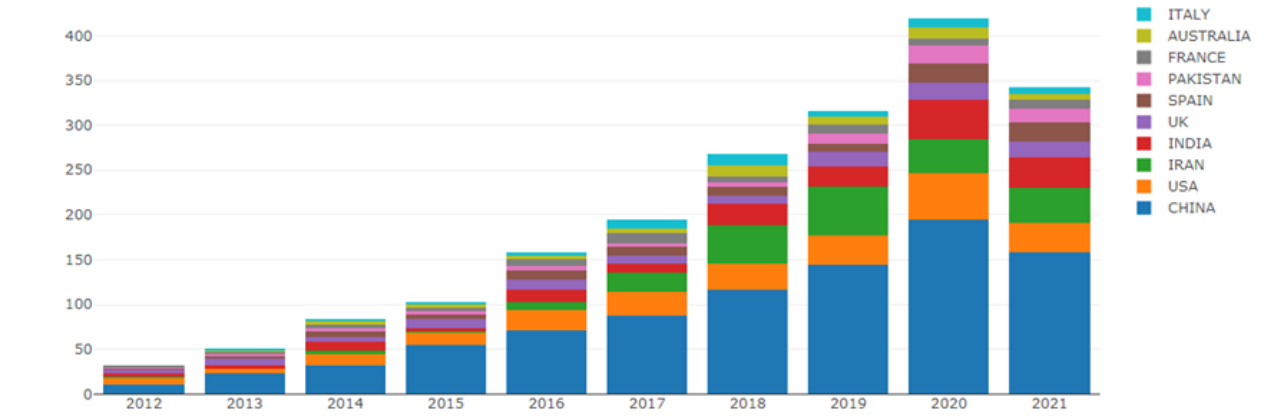
Figure 3. Number of papers published by countries each year. Table 1. Top 10 WOS of categories, publication titles and